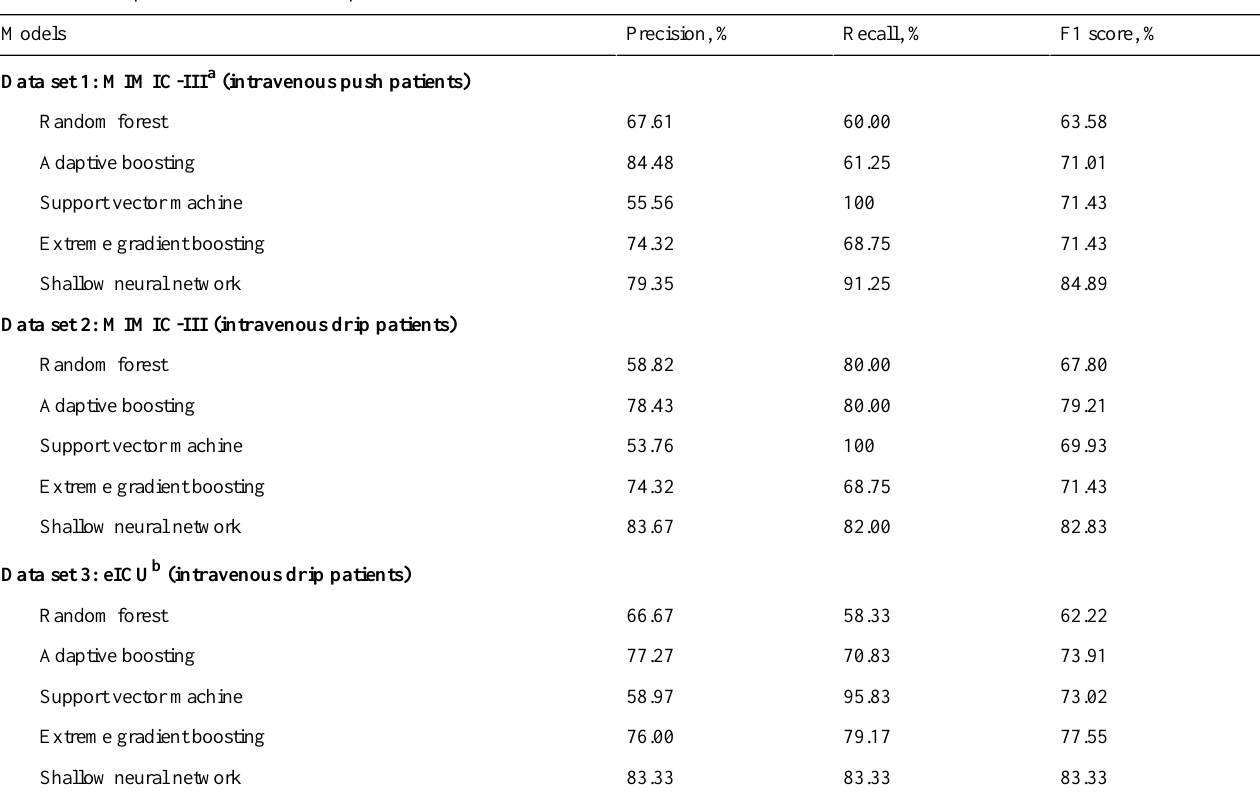
F1 score, %Recall, %Precision, %Models